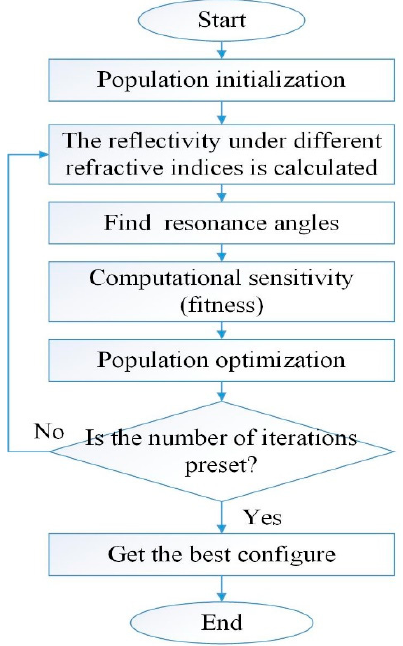
Figure 2. General flow chart of the overall operation.